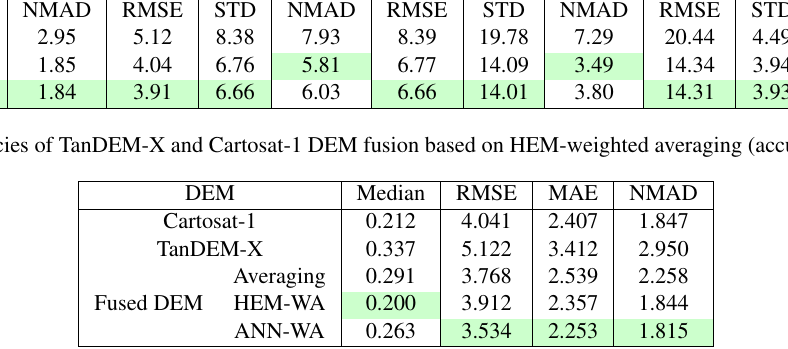
Table 3. Results of fusion of TanDEM-X and Cartosat-1 DEM (in meter) by using weight maps generated from different methods